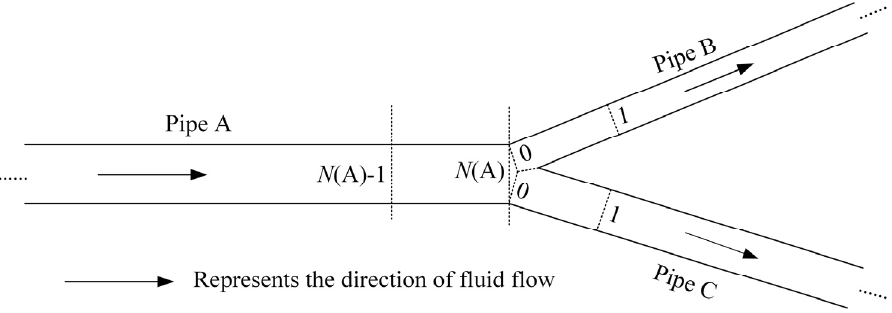
Figure 3. Bifurcated pipe interface mesh division diagram.